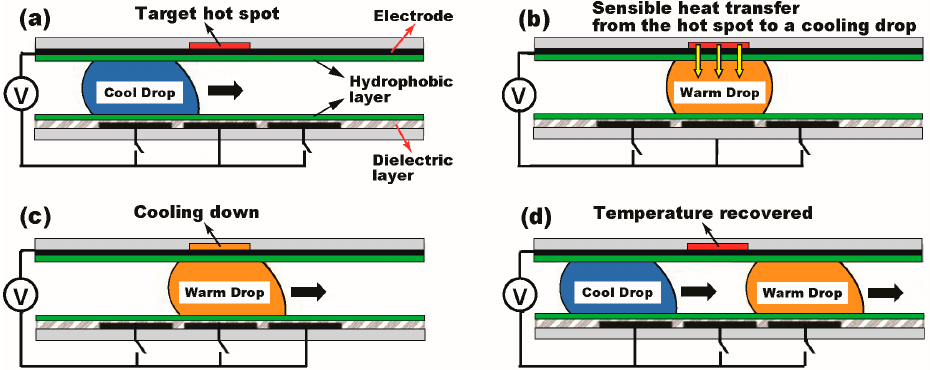
Figure 1. A hot spot cooling approach based on digital microfluidic (DMF) technology. ( a ) Cooling liquid is sandwiched between the top and bottom plates coated with a hydrophobic layer; ( b , c ) By sequentially addressing digitized electrodes, a droplet is rapidly transported to the target heating source (i.e., hot spot) where the heat is transferred from the hot spot to the cooling droplet and the temperature lowers down; ( d ) Then, the droplet leaves for a heat sink to release the heat to outside. These processes are rapidly repeated to keep mitigating the hot spot temperature. The DMF-based cooling method mainly uses sensible heat transfer for thermal rejection from the hot spot. However, such a single-phase cooling approach limits the level of applicable heat flux.